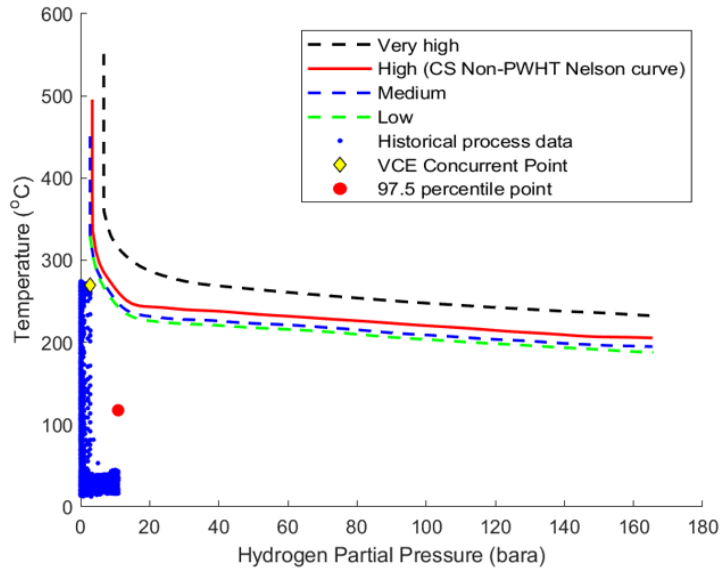
Figure 2. VCE visualization of the HTHA threat assessment for a single equipment item operating for a period of several years. for a period of several